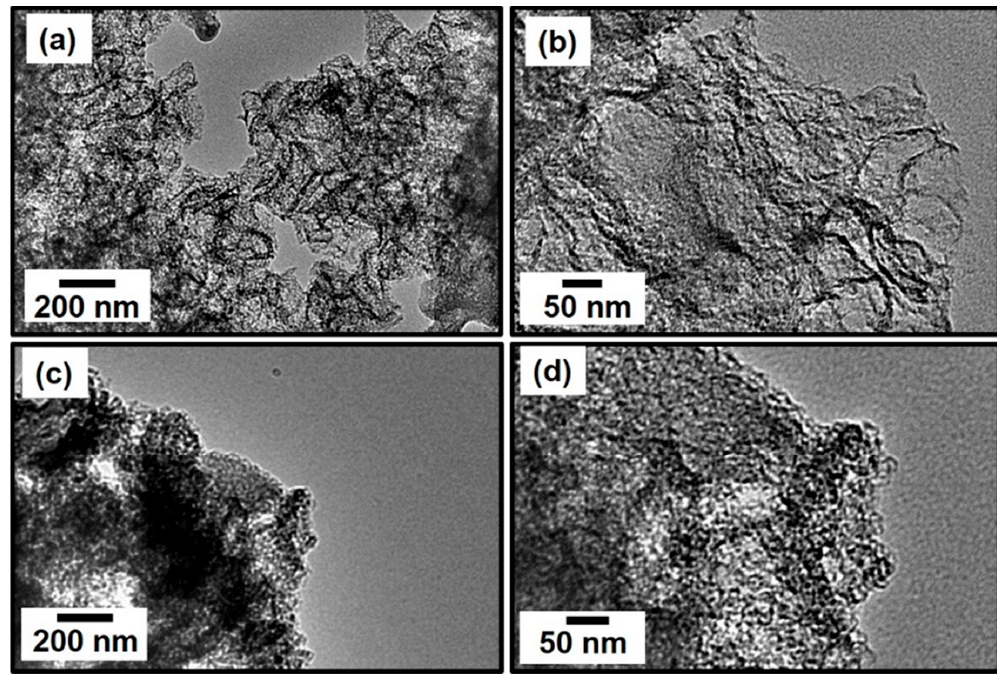
Figure 3. TEM images of ( a ) NPC 800 at the 200 nm scale, ( b ) NPC 800 at the 50 nm scale, ( c ) NPC 900 at the 200 nm scale and ( d ) NPC 900 at the 50 nm scale. Table 1. Surface and porous properties of the NPC